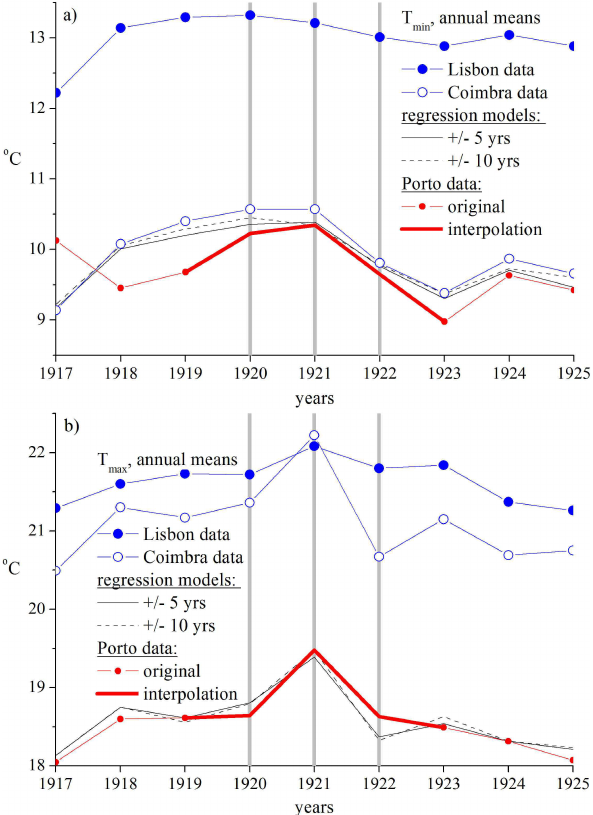
Figure 2. Variations of T min (a) and T max (b) measured in Lis- bon, Coimbra and Porto-Serra do Pilar from 1917 to 1925 (annual means) and approximations by multiple regression models for time periods of ± 5 and ± 10yr around the gap – annual sums. Grey ver- tical lines mark the period of absent data. The bold red lines show the accepted